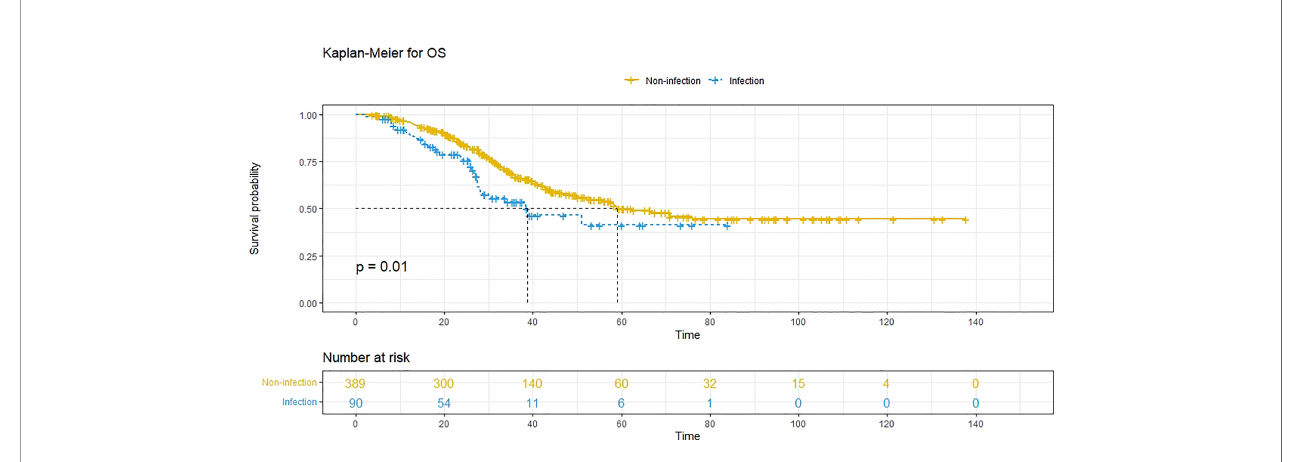
FIGURE 2 | Overall survival (OS) comparison in patients with postoperative infective complications (blue line) and patients without postoperative infective complications (yellow line). Infection, with postoperative infective complication. Non-infection, without postoperative infective